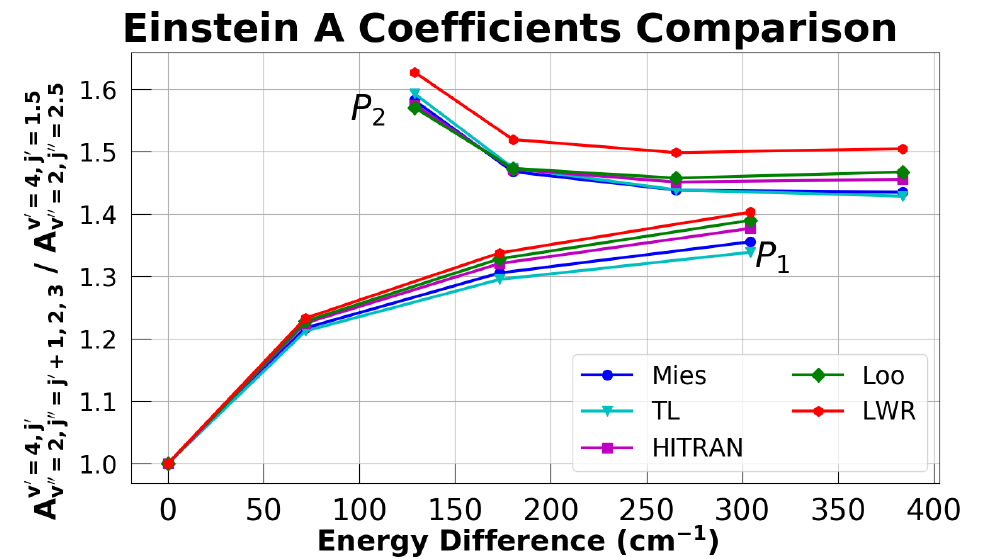
Figure 5. The five sets of Einstein A coefficients compared. Each set of Einstein A coefficients have been normalized by their P 1 ( 1 ) coefficient to allow for a